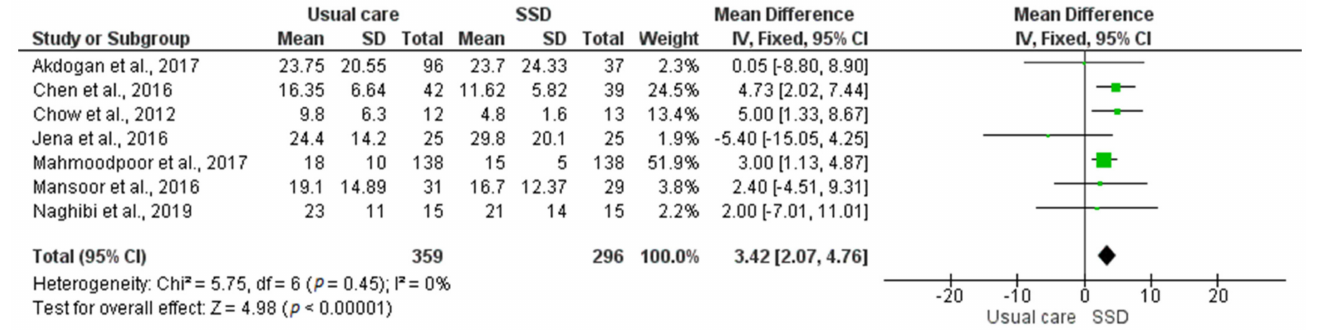
Figure 4. ICU length of stay in the usual care group vs. the SSD group.